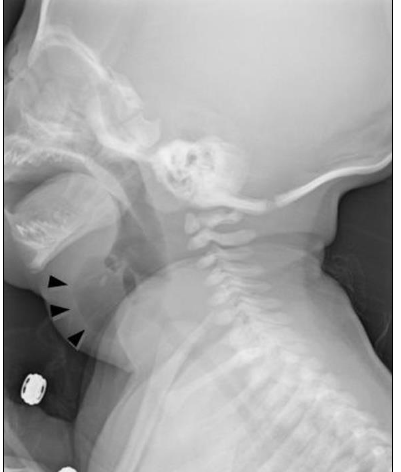
Figure 1: Left lateral neck X-ray finding: An air-fluid level within the mass in the left ante- rior neck.